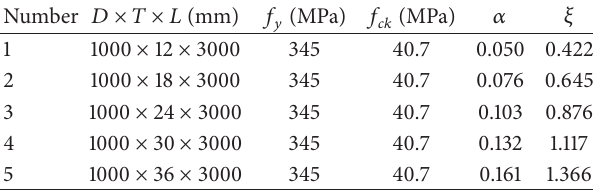
Table 4: Axially compressed short columns.